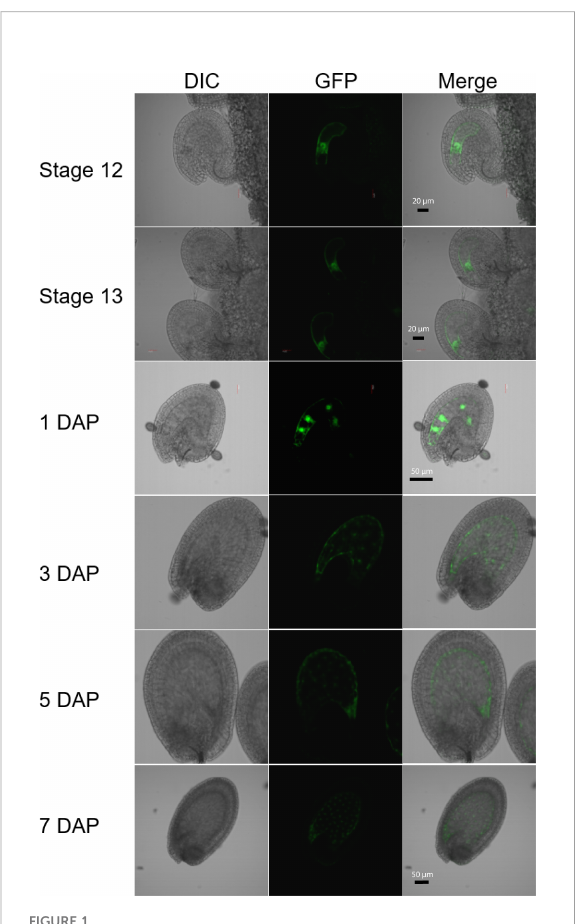
FIGURE 1 Expression of the H1.2 promoter::GFP transgene in Arabidopsis ovules and young developing seeds. Ovules and seeds with expression of H1.2 promoter : GFP transgene were photographed using confocal fl uorescence microscope. Ovules at fl ower stage 12 and stage 13 and seeds at 1, 3, 5, and 7 DAP were hand-dissected for imaging. The GFP signal is shown in green. DAP, Days After Pollination; DIC, Differential Interference Contrast. Scale bars: State 12 and 13, bar = 20 um; 1-5 DAP, bar = 50 um; 7 DAP, bar = 50